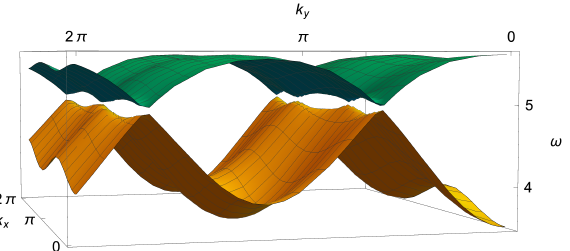
Figure 6: (Color online.) The two spin wave bands ω ± when a strong in-plane field is present. The parameters are chosen J